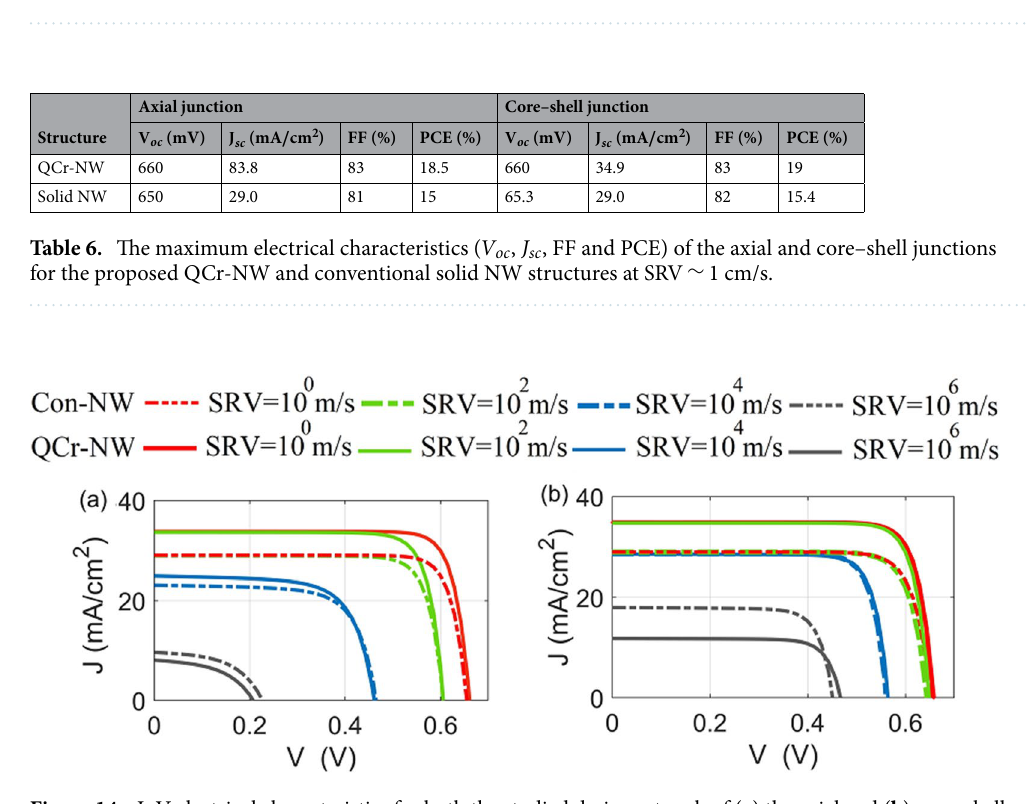
Figure 14. J–V electrical characteristics for both the studied designs at each of ( a ) the axial and ( b ) core–shell junctions at different SRVs